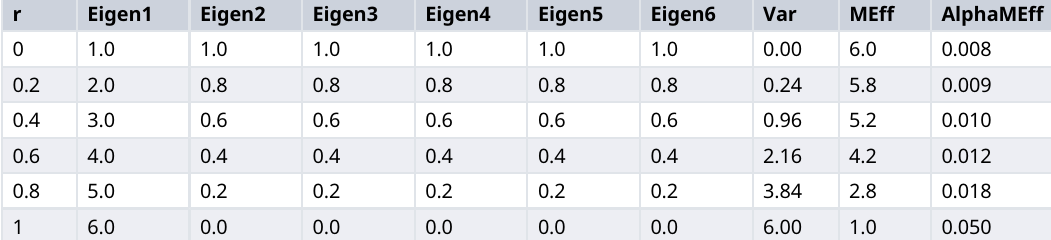
Table 1. Eigenvalues, MEff and AlphaMEff with 6 outcome